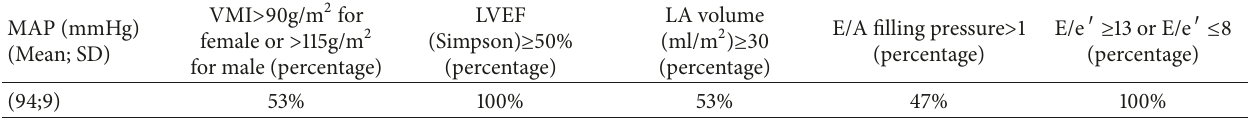
Table 2: Parameters of echocardiography